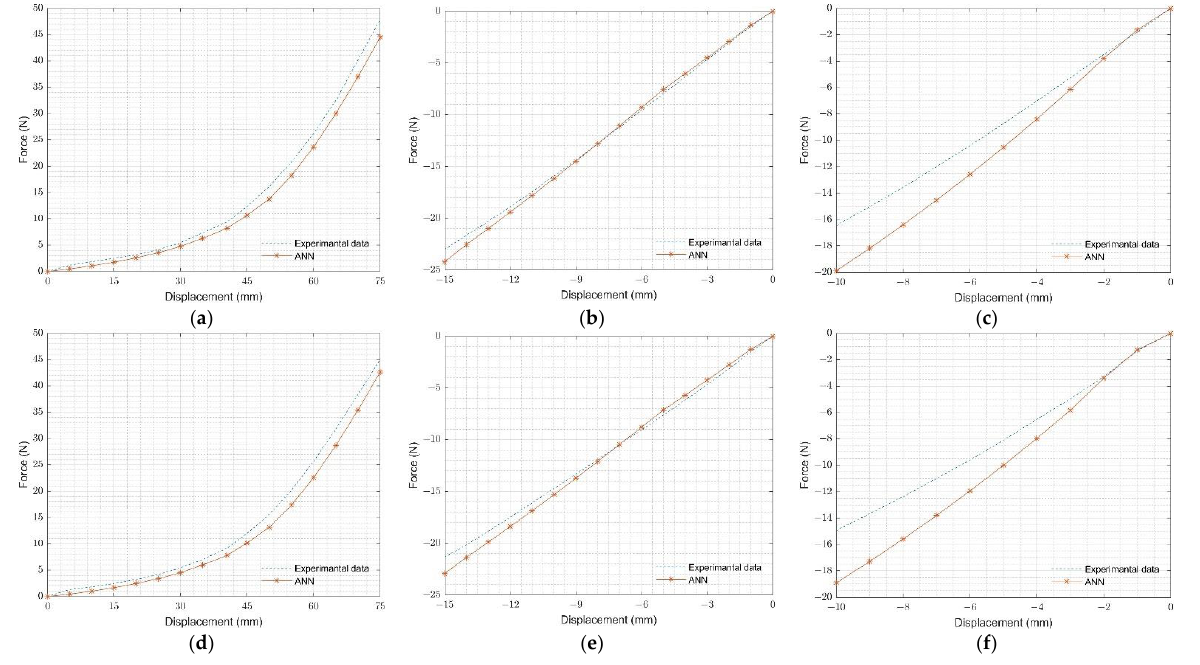
Figure 14. Comparison of experimental and FEA results for neoprene rubber for ( a ) O-ring tension test at 50 ° C, ( b ) O-ring compression test at 50 °C , ( c ) O-ring multi-contact test at 50 °C , ( d ) O-ring tension test at 80 °C , ( e ) O-ring compression test at 80 °C , and ( f ) O-ring multi-contact test 80 °C .